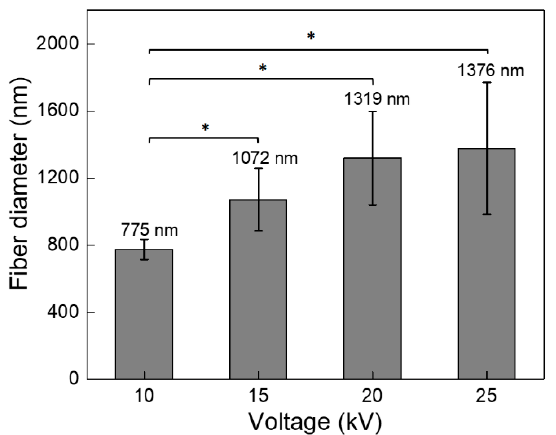
Figure 3. Average fiber diameter of scaffolds as a function of the applied voltage. The standard deviation is included. * Statistical changes were obtained by comparing the lowest values with 15, 20, and 25 kV.